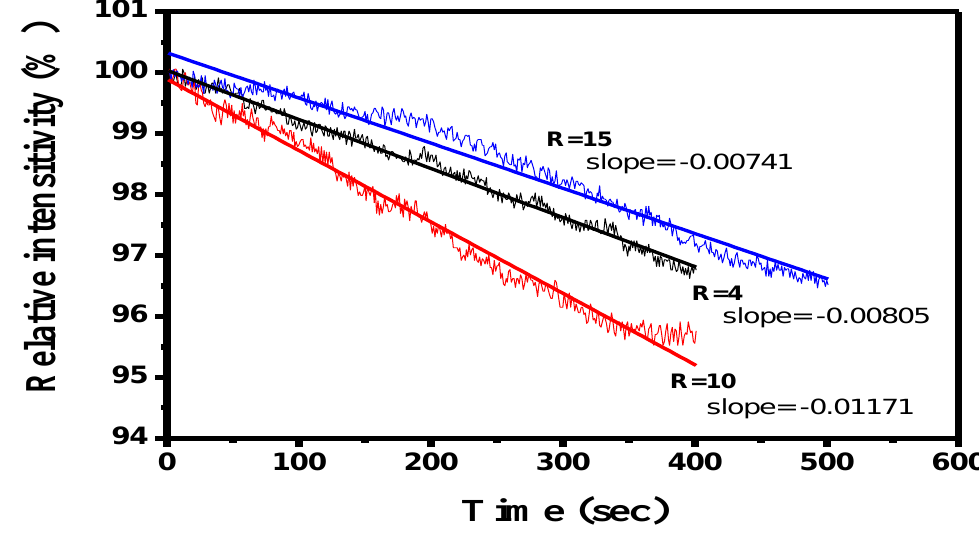
Figure 8. The comparative effect of the molal ratio of H probe with SiO sol-gel coating in detecting the HF solution (3.0%) at R = 4, R = 10, and 2 R = 15, respectively (the formation of bulk SiO standing for 3